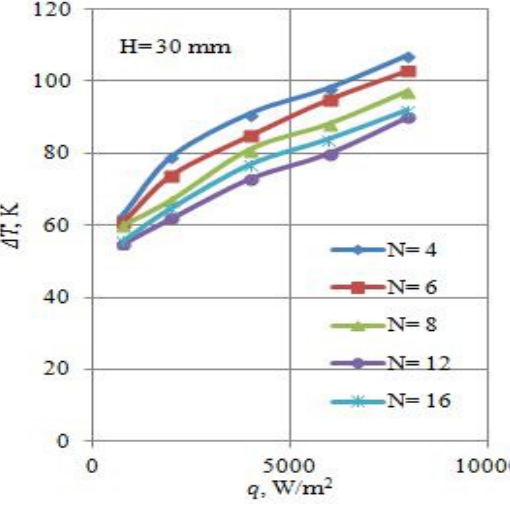
Fig. 4. Effect of fins number on the longitudinal fins.